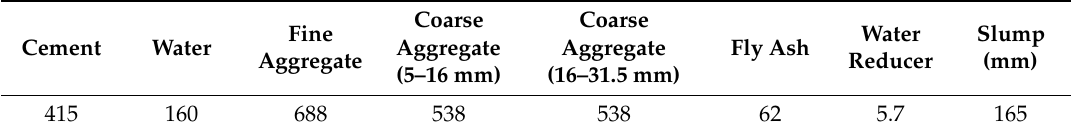
Table 2. Concrete mix proportion (kg/m 3 ).